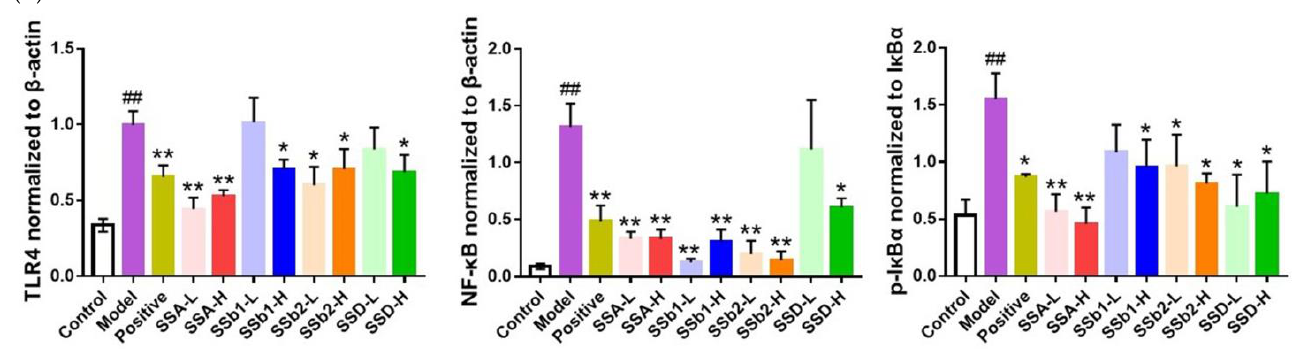
Figure 8. Effects of SSA, SSb1, SSb2, and SSD on protein expression levels of TLR4, NF- кB, p - IκBα , and IκBα in lung tissues from LPS-induced ALI mice ( n = 3, means ± SD s). ( a ) The expression levels of TLR4, NF- κB , and p- IκBα/IκBα proteins were analyzed using Western blotting. ( b ) The statistical analysis for Western blotting using a one-way ANOVA. ## p < 0.01 vs. control group; * p < 0.05, ** p < 0.01 vs. LPS-induced model group.